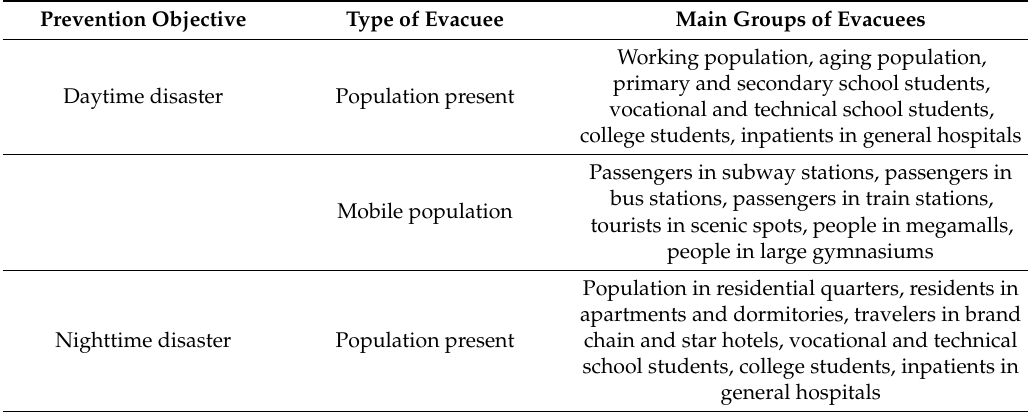
Table 1. Main groups of potential evacuees under the day and night disaster prevention